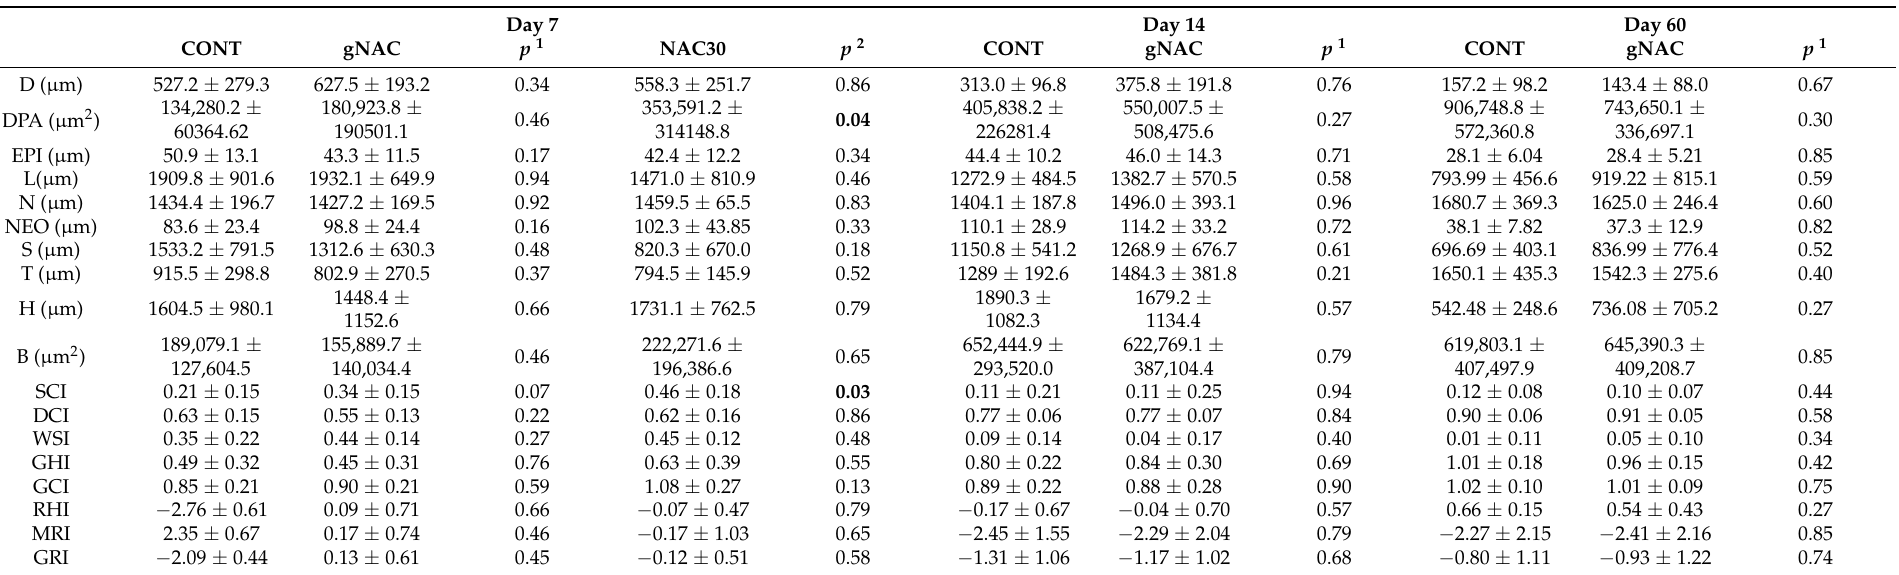
Table 1. Data summarized from histomorphometrical analysis of HE- and TM-stained samples. D—depth of the wound, DPA—dermal proliferation area, E—thickness of the epidermis, L—length of the re-epithelialization zone, N—thickness of the natural dermis, NE—thickness of newly formed epidermis, S—distance between the borders of the wound, T—thickness of the connective tissue in the center of the wound, H, H0—distance between two hair follicles closest to the wound borders. H0 is the initial distance between the hair follicles (day 7), B, B0—dense scar tissue compartment, stained in blue. B0 is the total area of connective tissue in the center of the wound at day 7, SCI—superficial contraction index, DCI—deep contraction index, WSI—wound severity index, GHI—global healing index, GCI—global contraction index, HRI—hair remodeling index, MRI—matrix remodeling index, GRI—global